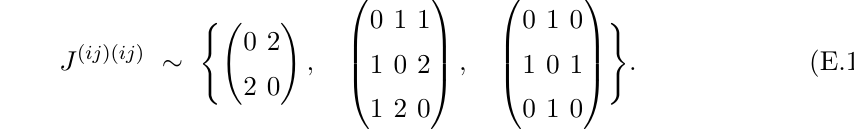
Figure 33 . Open two-points (up) and edge-adjacency graphs (down), respectively corresponding to (E.11). In the edge-adjacency graphs, p (cid:13) represents a Wick-edge. The edge (or edges) between p (cid:13) and q (cid:13) means they are (multiply)